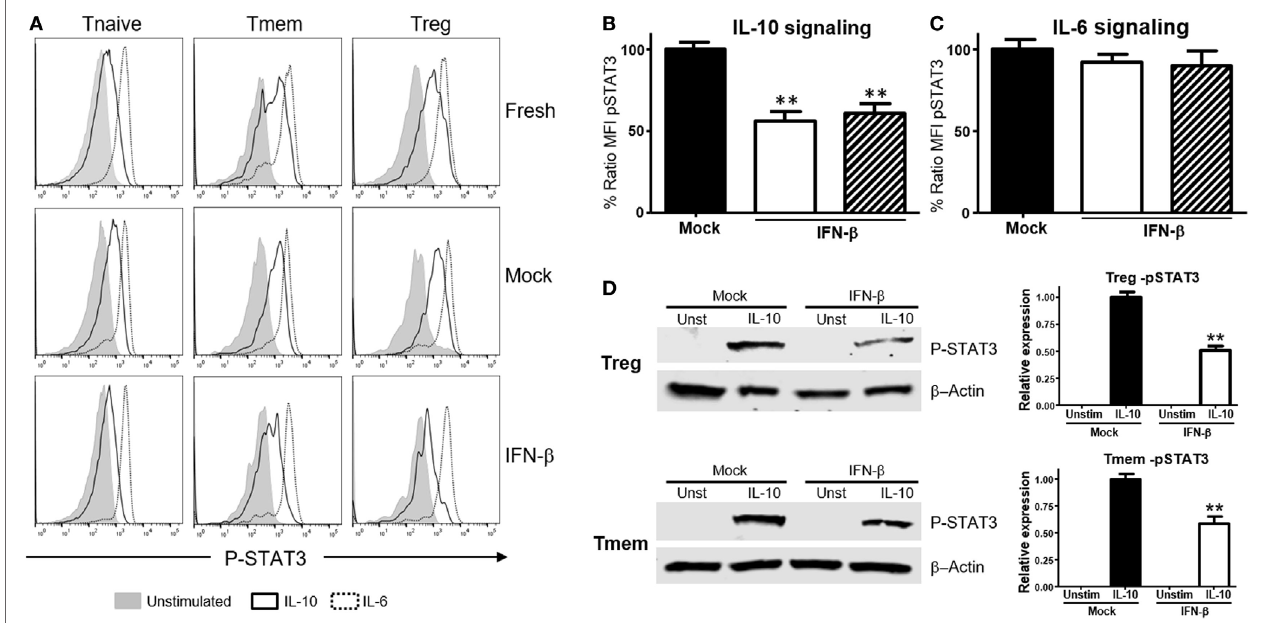
FigUre 2 | Exposure to IFN- β induces a selective inhibition of interleukin-10 (IL-10) signaling in CD4 memory T cells (Tmem) and regulatory T cell (Treg) irrespective of the strain of origin. (a–c) Purified T cells from C57BL/6 mice were freshly stimulated or cultured for 48 h in complete media with or without IFN- β (5 ng/ml), and rested in cytokine-free media for six additional hours. Cells were then either left untreated or stimulated with IL-10 (40 ng/ml) or IL-6 (40 ng/ml) for 20 min, and the levels of P-STAT3 in CD4 T cell subpopulations were measured by Phospho-flow as in Figure 1 . (a) Representative histograms of the mean fluorescence intensity (MFI) levels of P-STAT3 in the different CD4 T cell subpopulations of fresh, mock, and IFN- β exposed T cells after IL-10 and IL-6 stimulation. (B,c) Graph bars that compare the percentage of P-STAT3 MFI ratio between IFN- β exposed and not exposed (mock) cultured Tmem and Tregs after IL-10 (B) or IL-6 (c) stimulation. Ratio MFI was calculated comparing the coefficient index of P-STAT3 after stimulation between the two different culture conditions, considering levels in mock cells as 100% of expression. Data from n = 6 individual experiments are shown and expressed as % of ratio MFI ± SEM, ** p < 0.01, Mann–Whitney U test. (D) T cells from C57BL/6-Foxp3-GFP mice were cultured for 48 h in complete media with or without IFN- β (5 ng/ml), and then Tmem (CD4 + Foxp3-GFP − CD44 + ) and Treg (CD4 + Foxp3-GFP + ) subpopulations were flow sorted. After a 6 h resting phase, cells were left untreated or stimulated with IL-10 (40 ng/ml) for 20 min, lysed and the levels of pSTAT3 compared to β -actin were measured by Western Blot. Data from n = 3 individual experiments are shown and expressed as a relative expression with the control ± SEM, ** p < 0.01, Student’s t